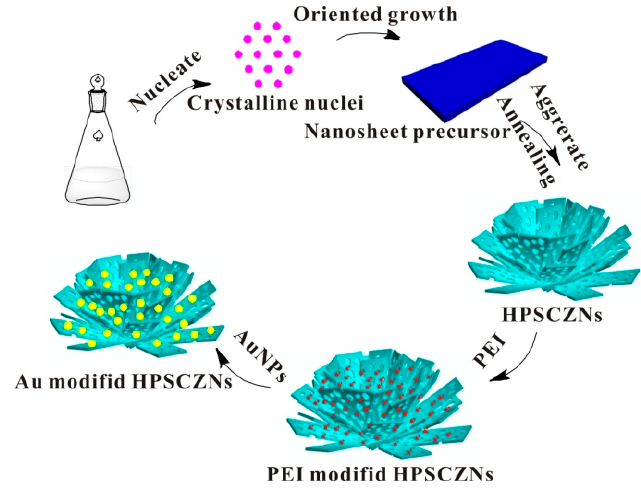
Figure 5. Schematic illustration of the formation process of the Au-modified HPSCZNs.